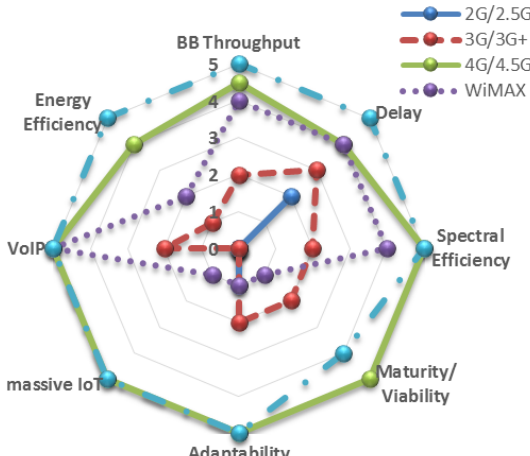
Figure 10 . Comparison of technologies for BB sub-layer in smart